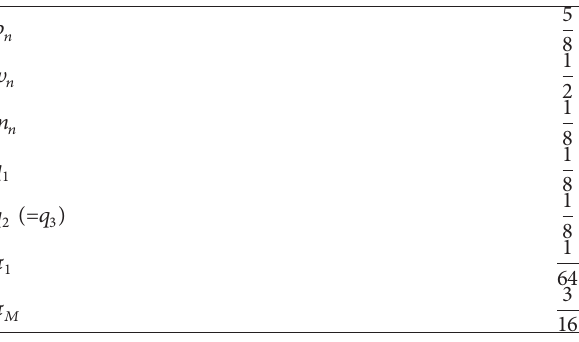
Table10:EquilibriumoutcomeforthecasewhereonlytheNBexists in the